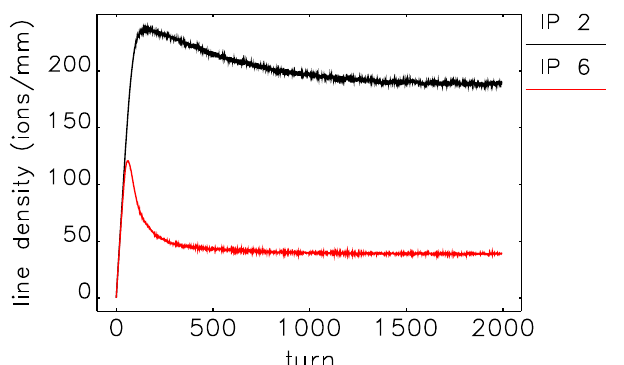
FIG. 3. Ion density at different interaction points in the baseline APS simulation.